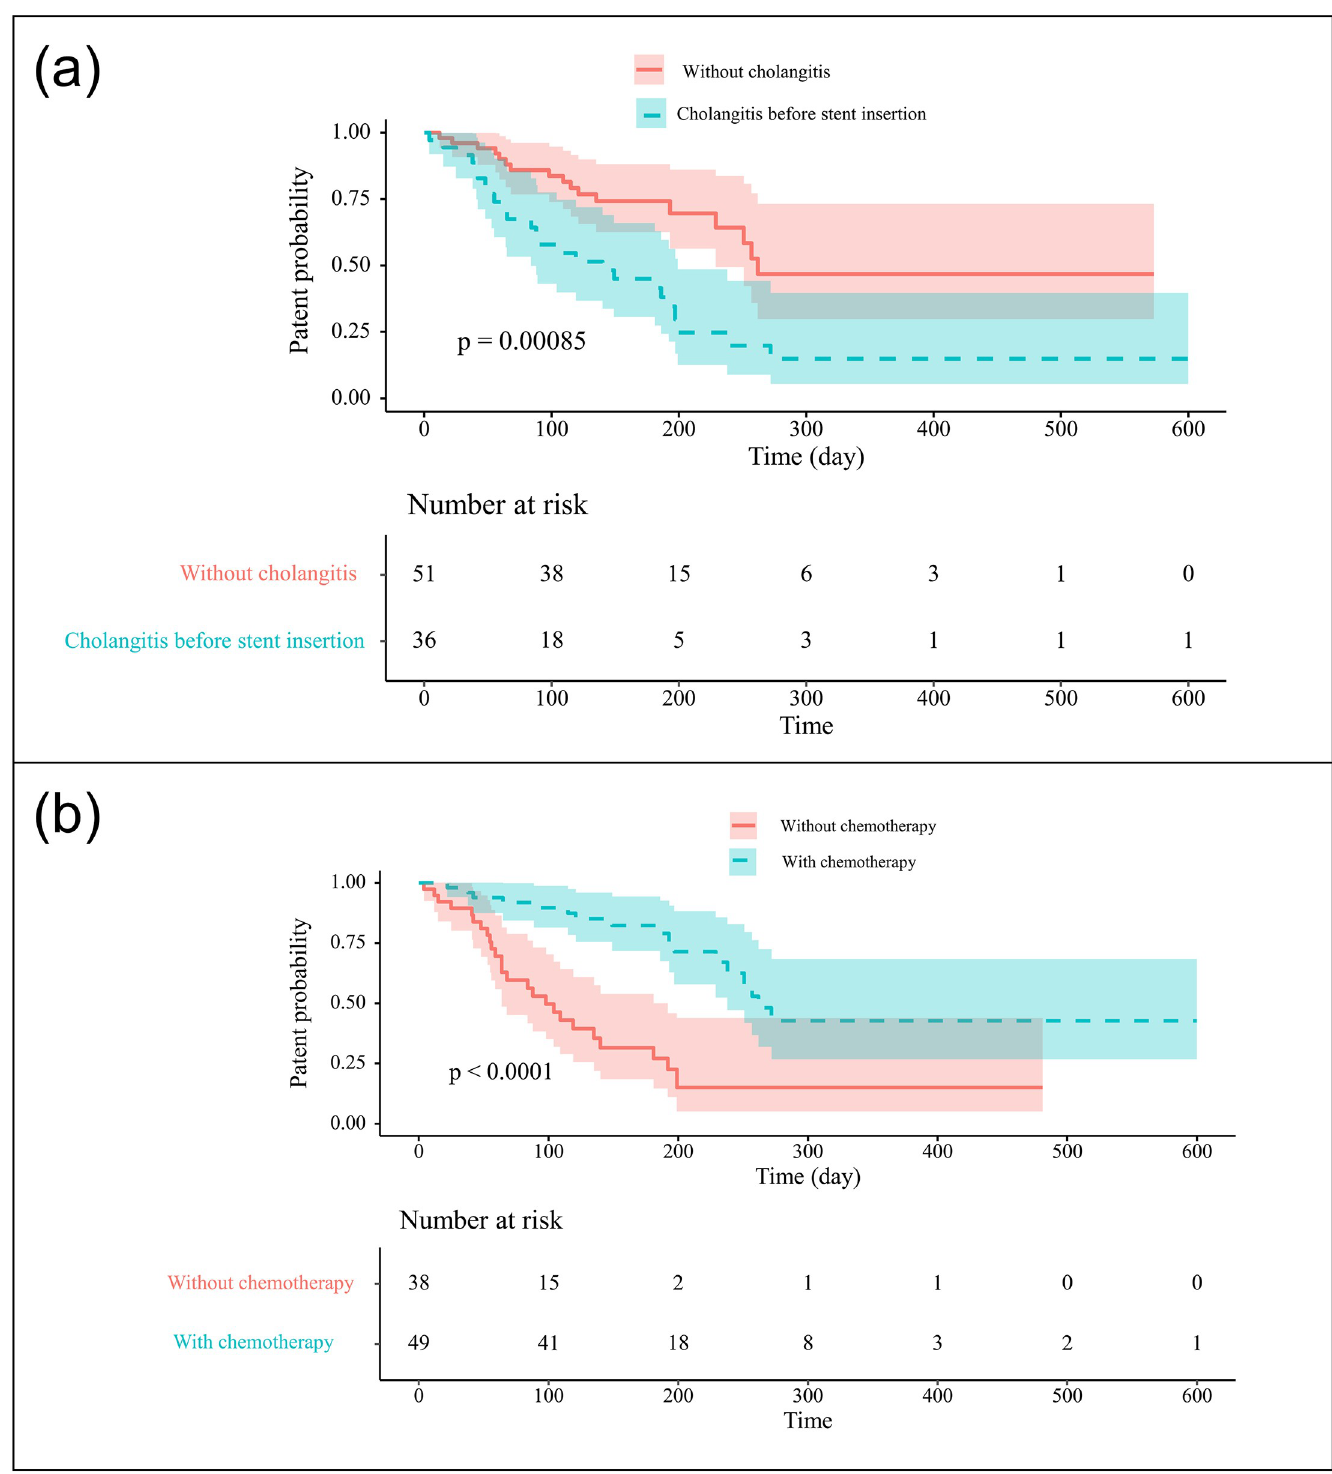
Fig 2. Kaplan-Meier curve showing the cumulative stent patency. (a) Presence of cholangitis before the procedure; (b) Subsequent chemotherapy.